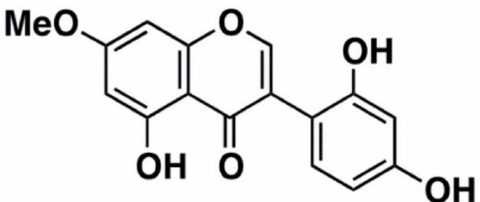
Figure 1. Schematic chemical structure of cajanin.